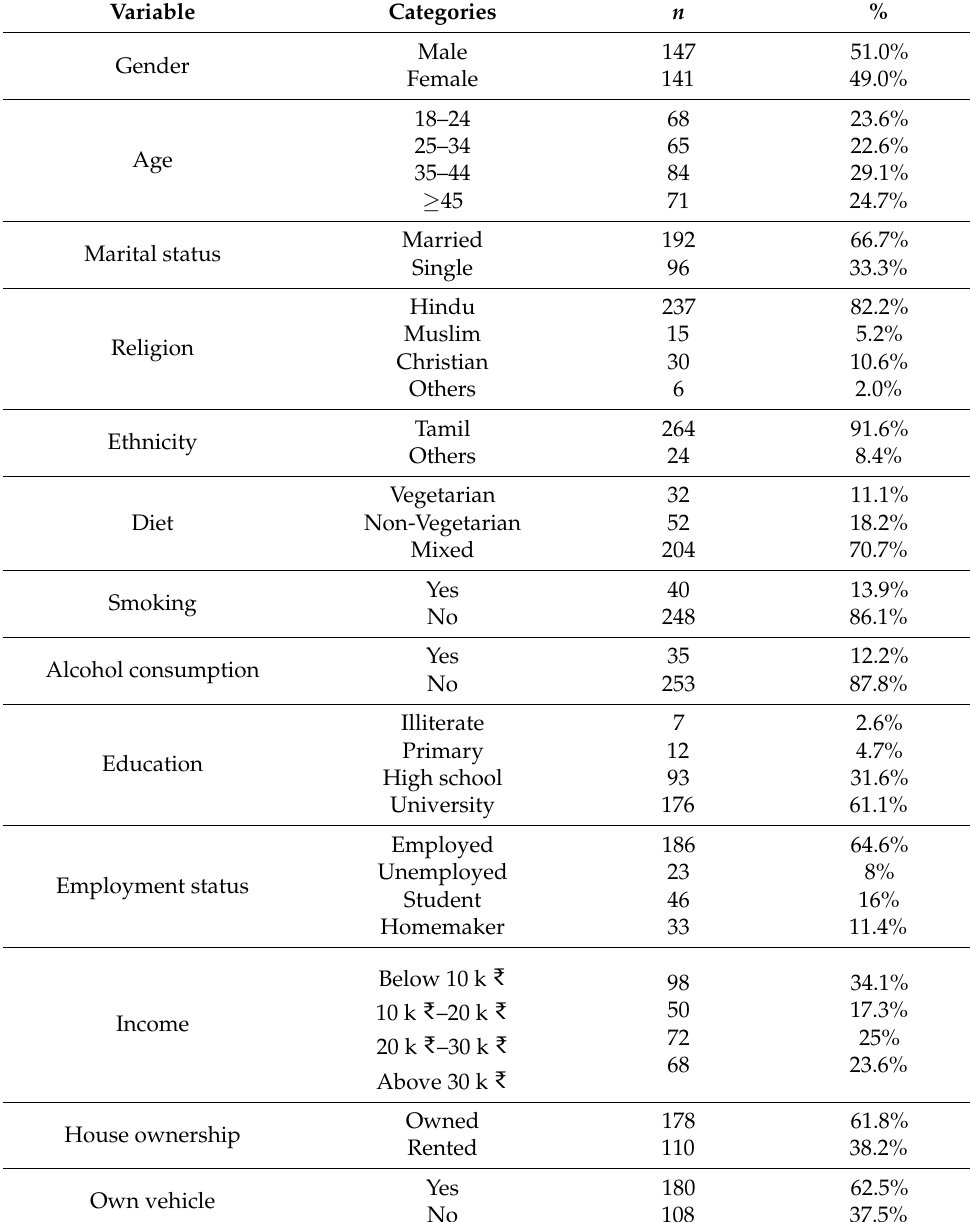
Table 4. Sociodemographic and habits profile of the adult population ( n = 288), Tamil Nadu, India, 2021.